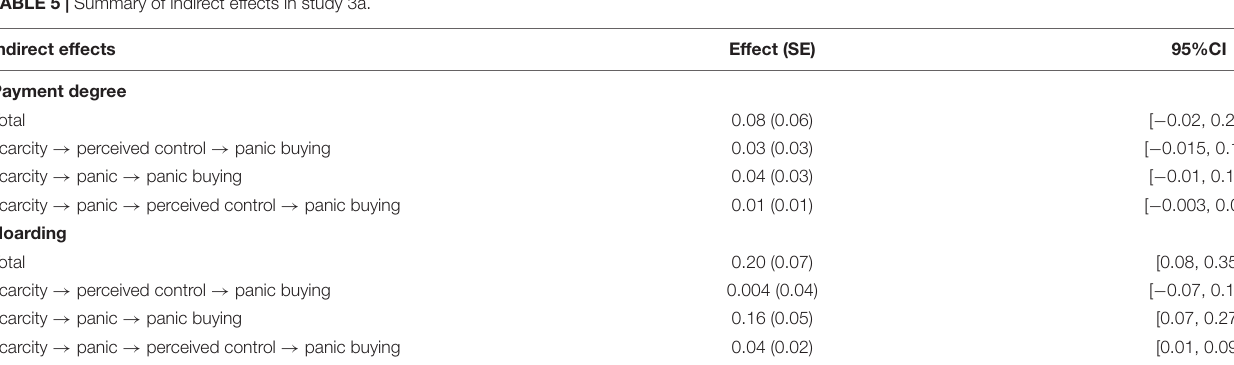
TABLE 5 | Summary of indirect effects in study